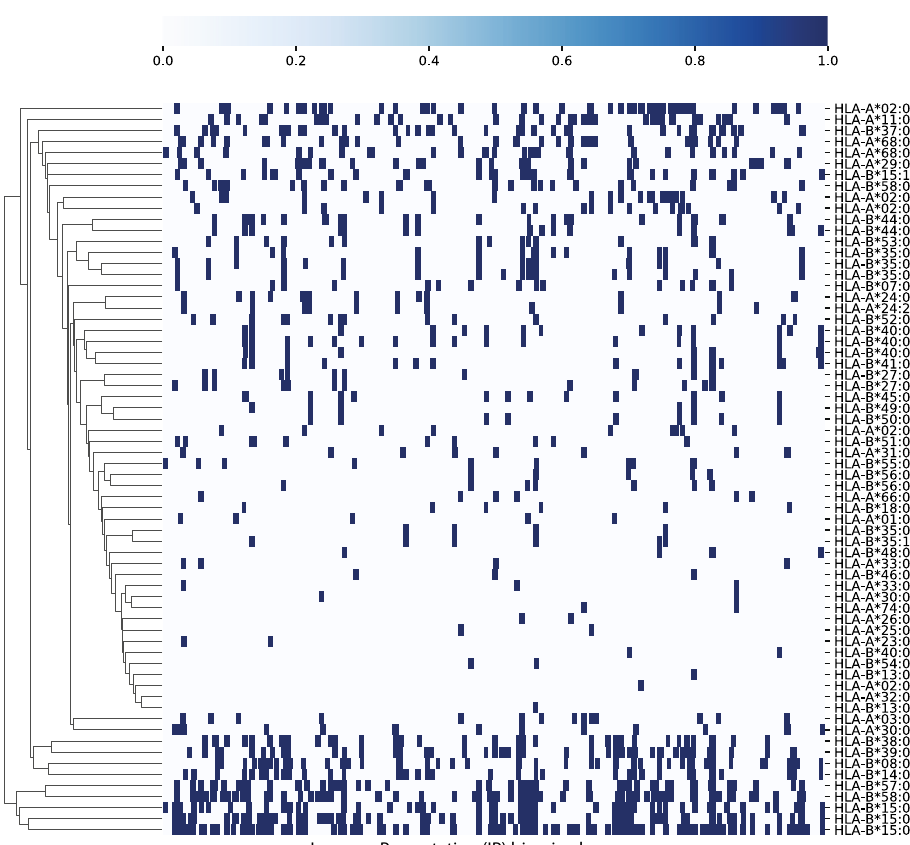
Figure 2. Hierarchical clustering of binary transformation of the epitope maps. Illustrated here for Class I CD8 epitopes in HLA-A and HLA-B alleles. Predictions for Class I greater than 0.7 are transformed to 1. Illustrated for the S-Protein here for demonstration purposes.